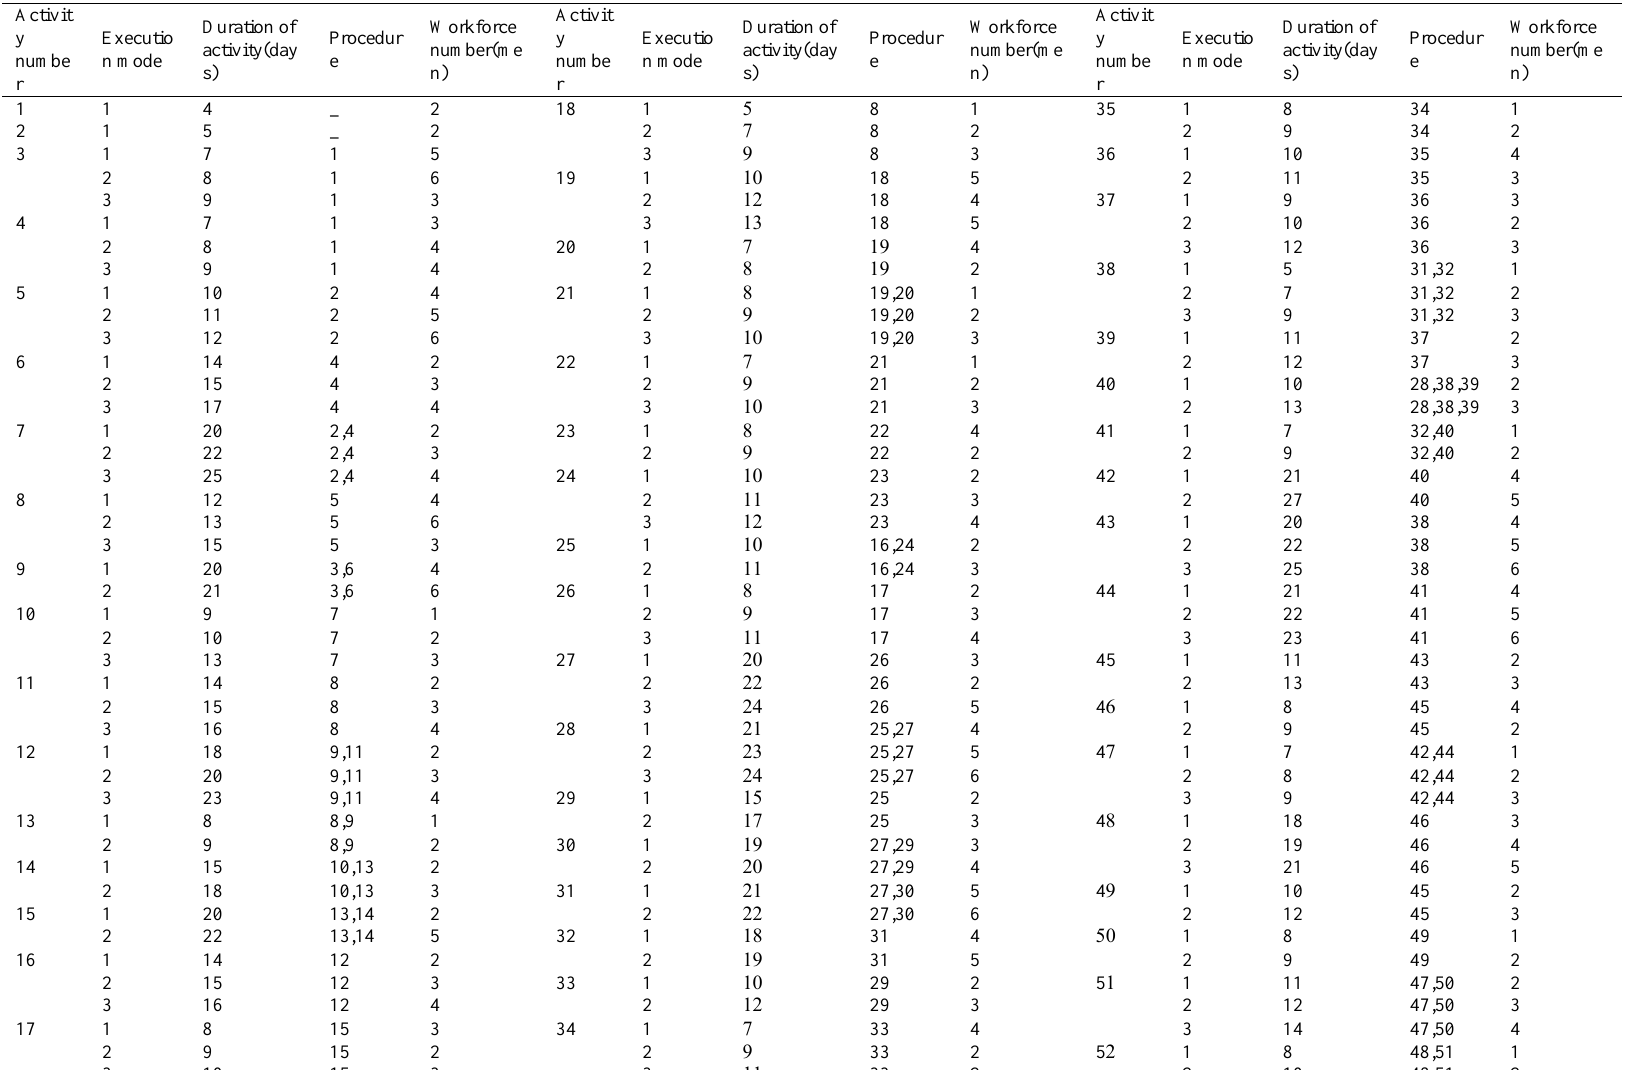
Table 10. Activity data of the real case study